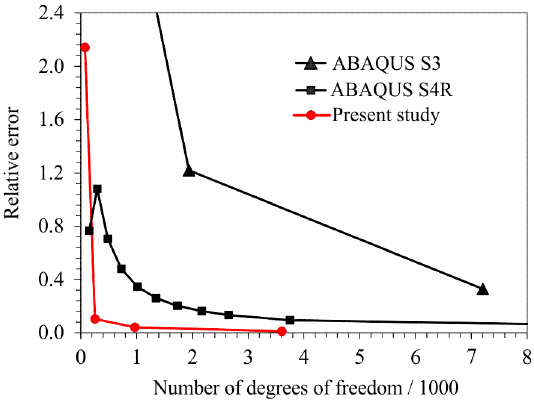
Figure 12. Relative error of midpoint deflection of the plate in relation to NDOF.